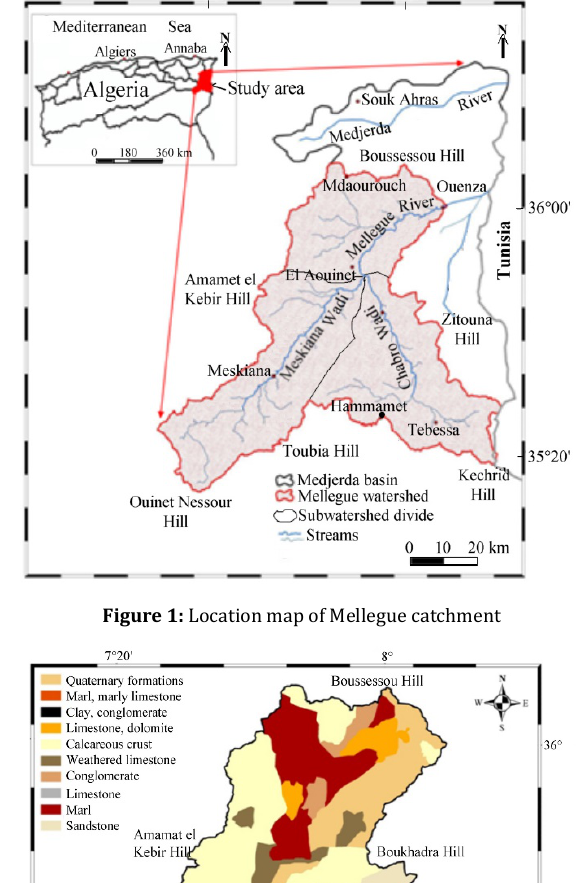
Figure 1: Location map of Mellegue catchment